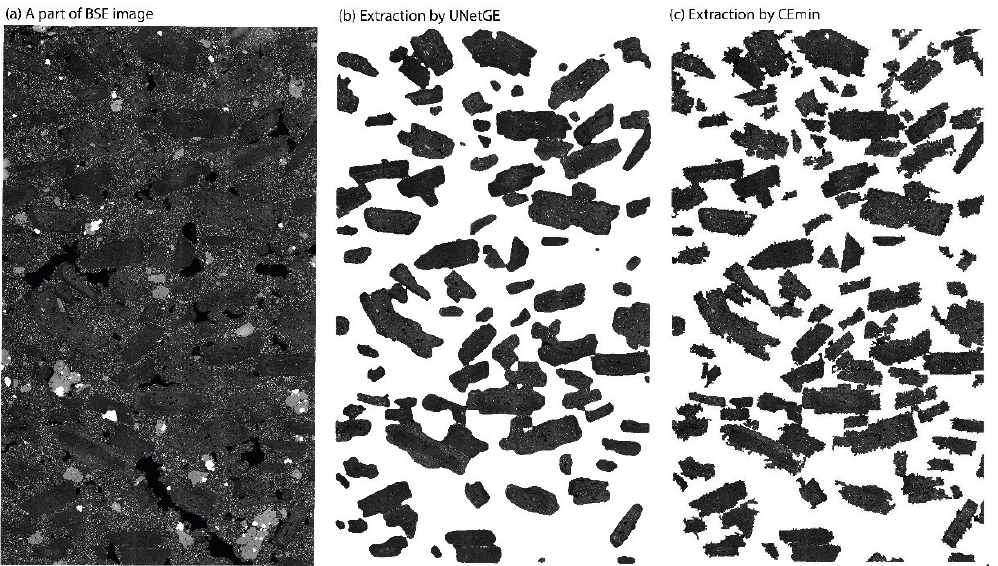
Figure 13. ( a ) A part of BSE image. ( b ) The direct grayscale extraction of this part of BSE without manual correction by UNetGE based on the trained model of BSE1 (Table 2). ( c ) The direct grayscale extraction of this part of BSE without manual correction by CEmin.